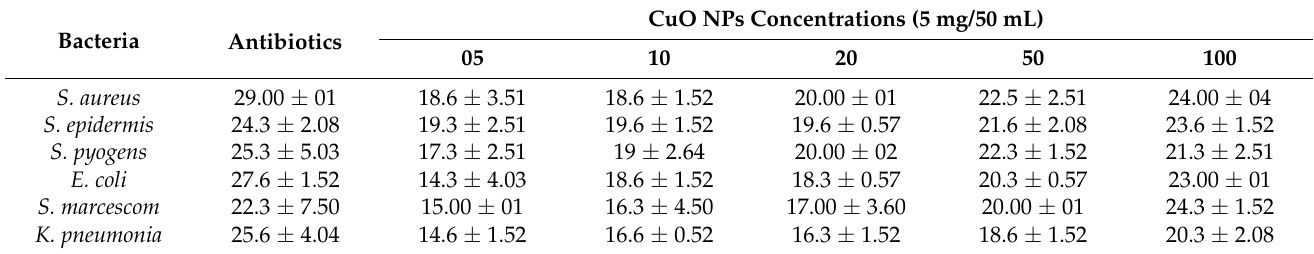
Table 1. Antibacterial activity of CuO NPs and antibiotic, the zone of inhibition was measured in millimeter (mm).